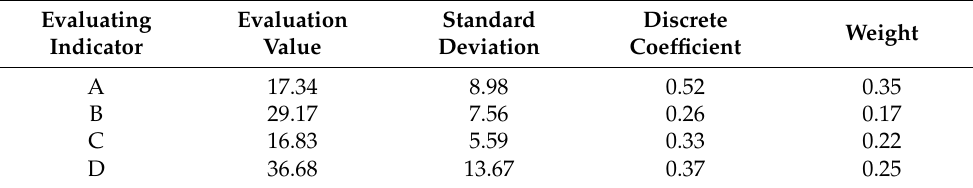
Table 2. Calculation Table of M-server